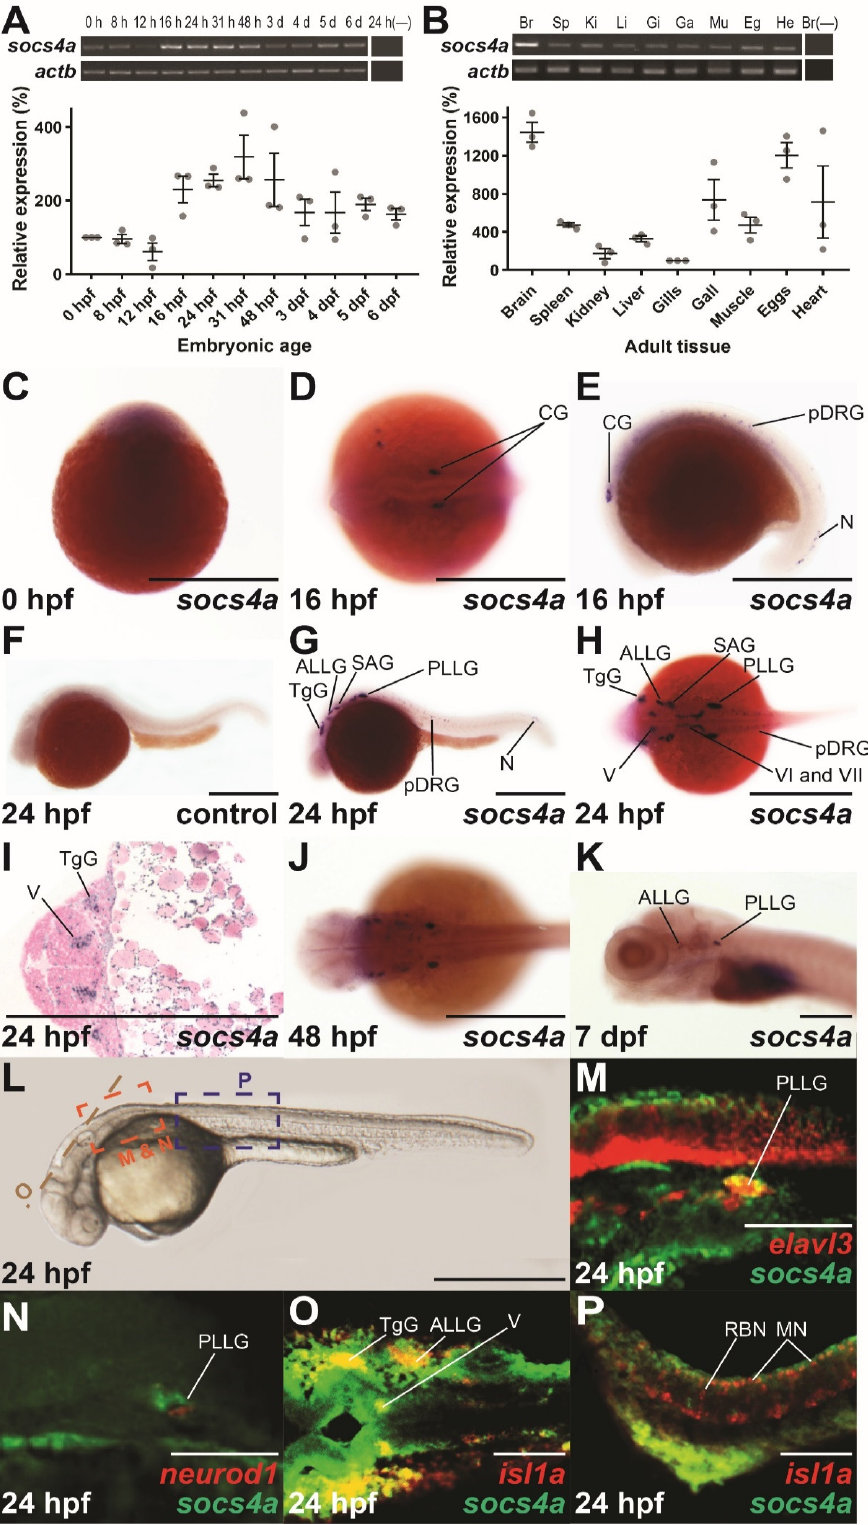
Figure 1. Spatio-temporal expression profile of socs4a . RT-PCR analysis of socs4a and control actb ( β -actin) from total RNA extracted from embryos at the indicated times post fertilization (( A ),